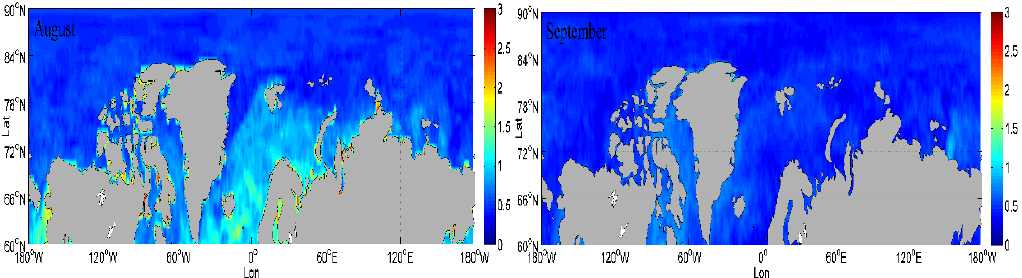
Figure 8. The average of 6-hour changes in visibility in August and September 2018, in the Arctic.